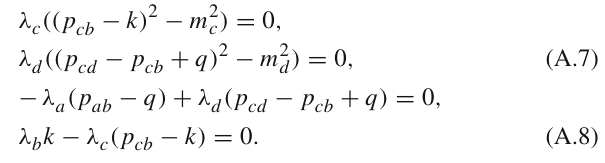
Fig. 21 One-gluon exchange between quarks b and d